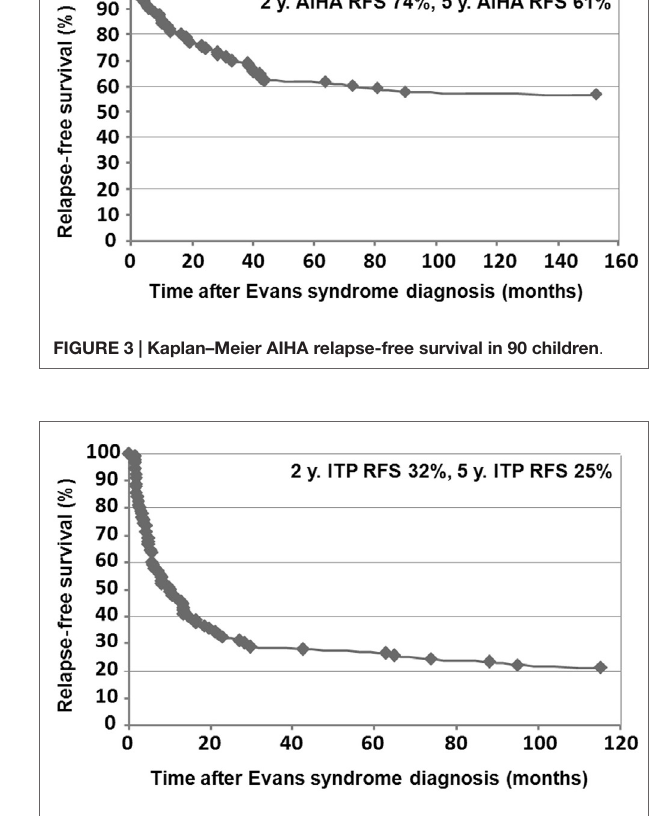
TaBle 2 | Variables associated with the necessity of a second-line treatment.